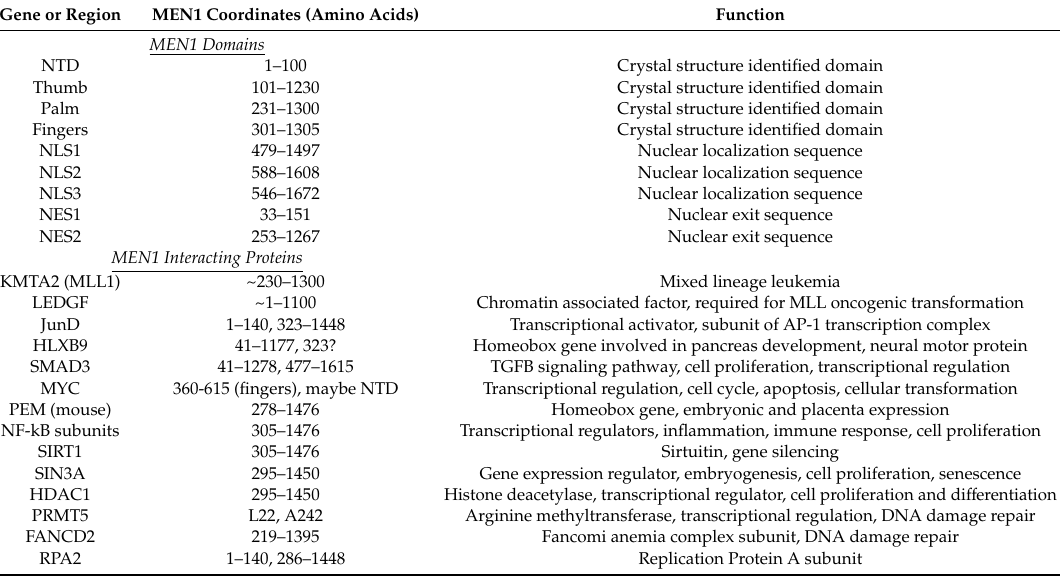
Figure 1. Structure and function of MENIN. ( A ) Schematic of MENIN highlighting identified domains and functional regions. ( B ) Relative positions of MENIN interaction proteins mapped on the structure in ( A ). Table 1. Coordinates and functions of MEN1 domains and interacting